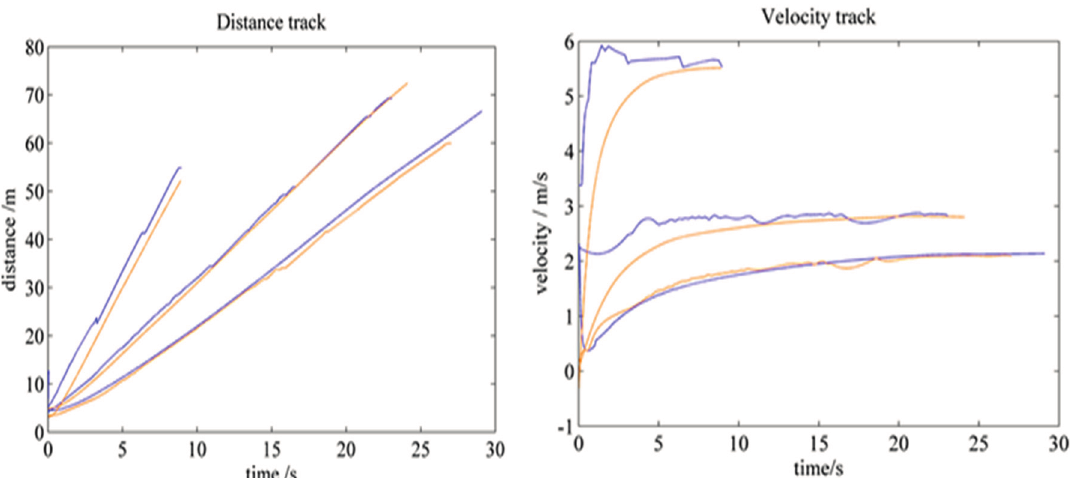
Figure 10. Tracking experiment on the distance and velocity of a vehicle under various